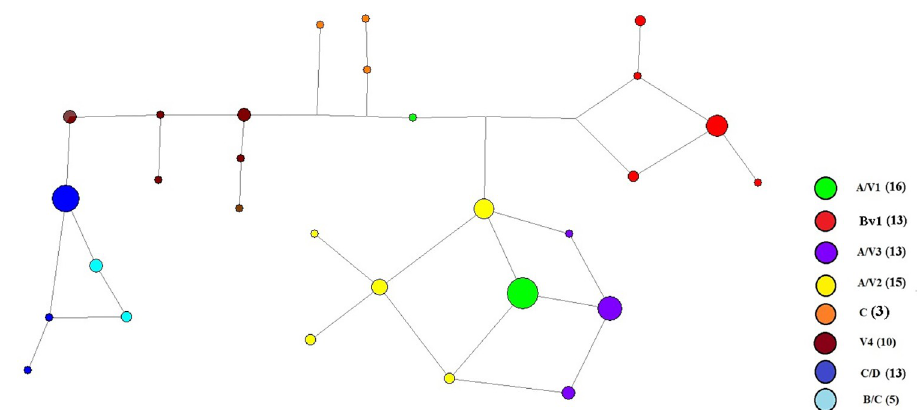
Fig 3. Median joining network analysis of P . falciparum samples collected in Amazon region in 2009–2010. The genetic relationships among parasites were constructed using the seven neutral microsatellite loci shown on S1 Table. The distinct lineages are rendered in different colors and circle sizes are proportional to the number of samples assigned to a particular lineage. The number of samples assigned to each lineage by Structure analysis are shown in parentheses. The pfhrp2-negative proportions for each lineage are show in bold.